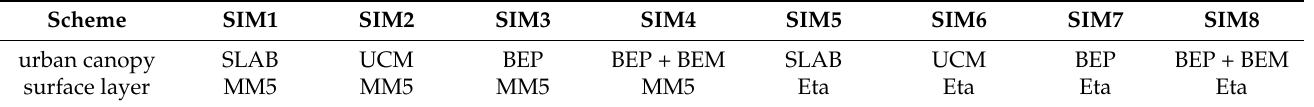
Table 1. Physical parameterization configuration of the simulation.